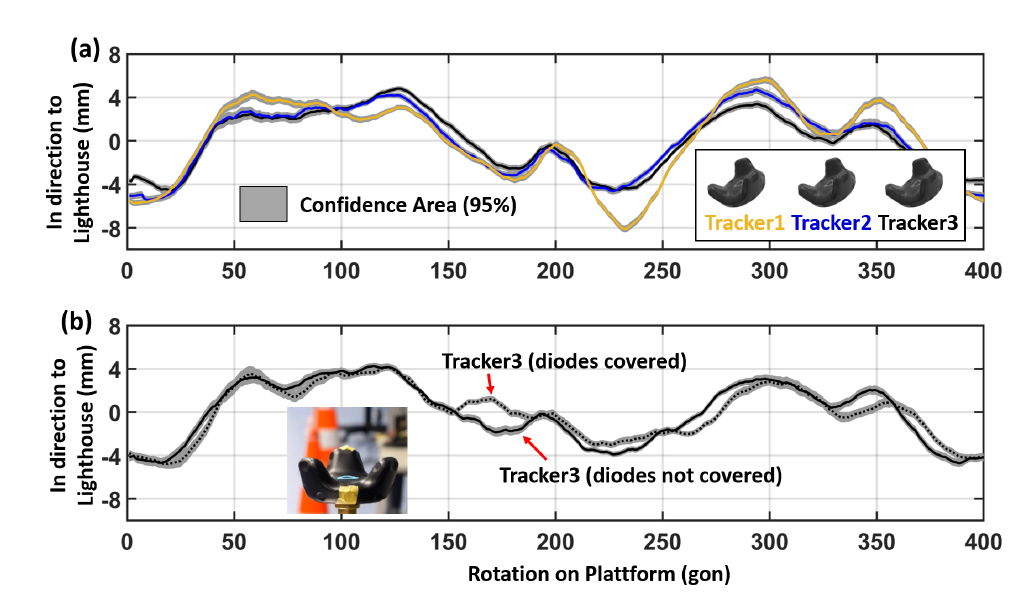
Figure 16. Deviation of the mean positions during the rotation test ( a ) with three different VR Trackers and ( b ) with covered IR diodes. Distance to lighthouse: 2 m.